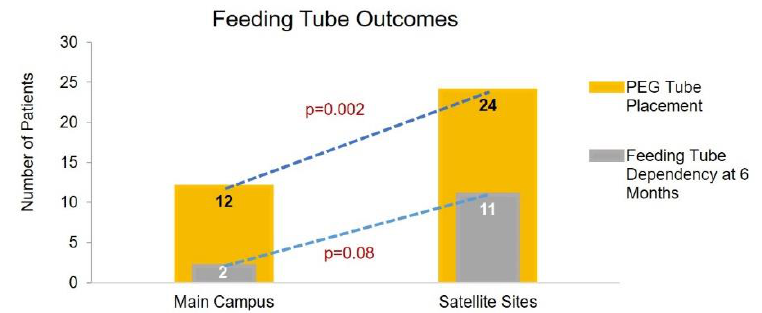
Figure 3. Feeding tube placement and 6-month dependency by treatment site.